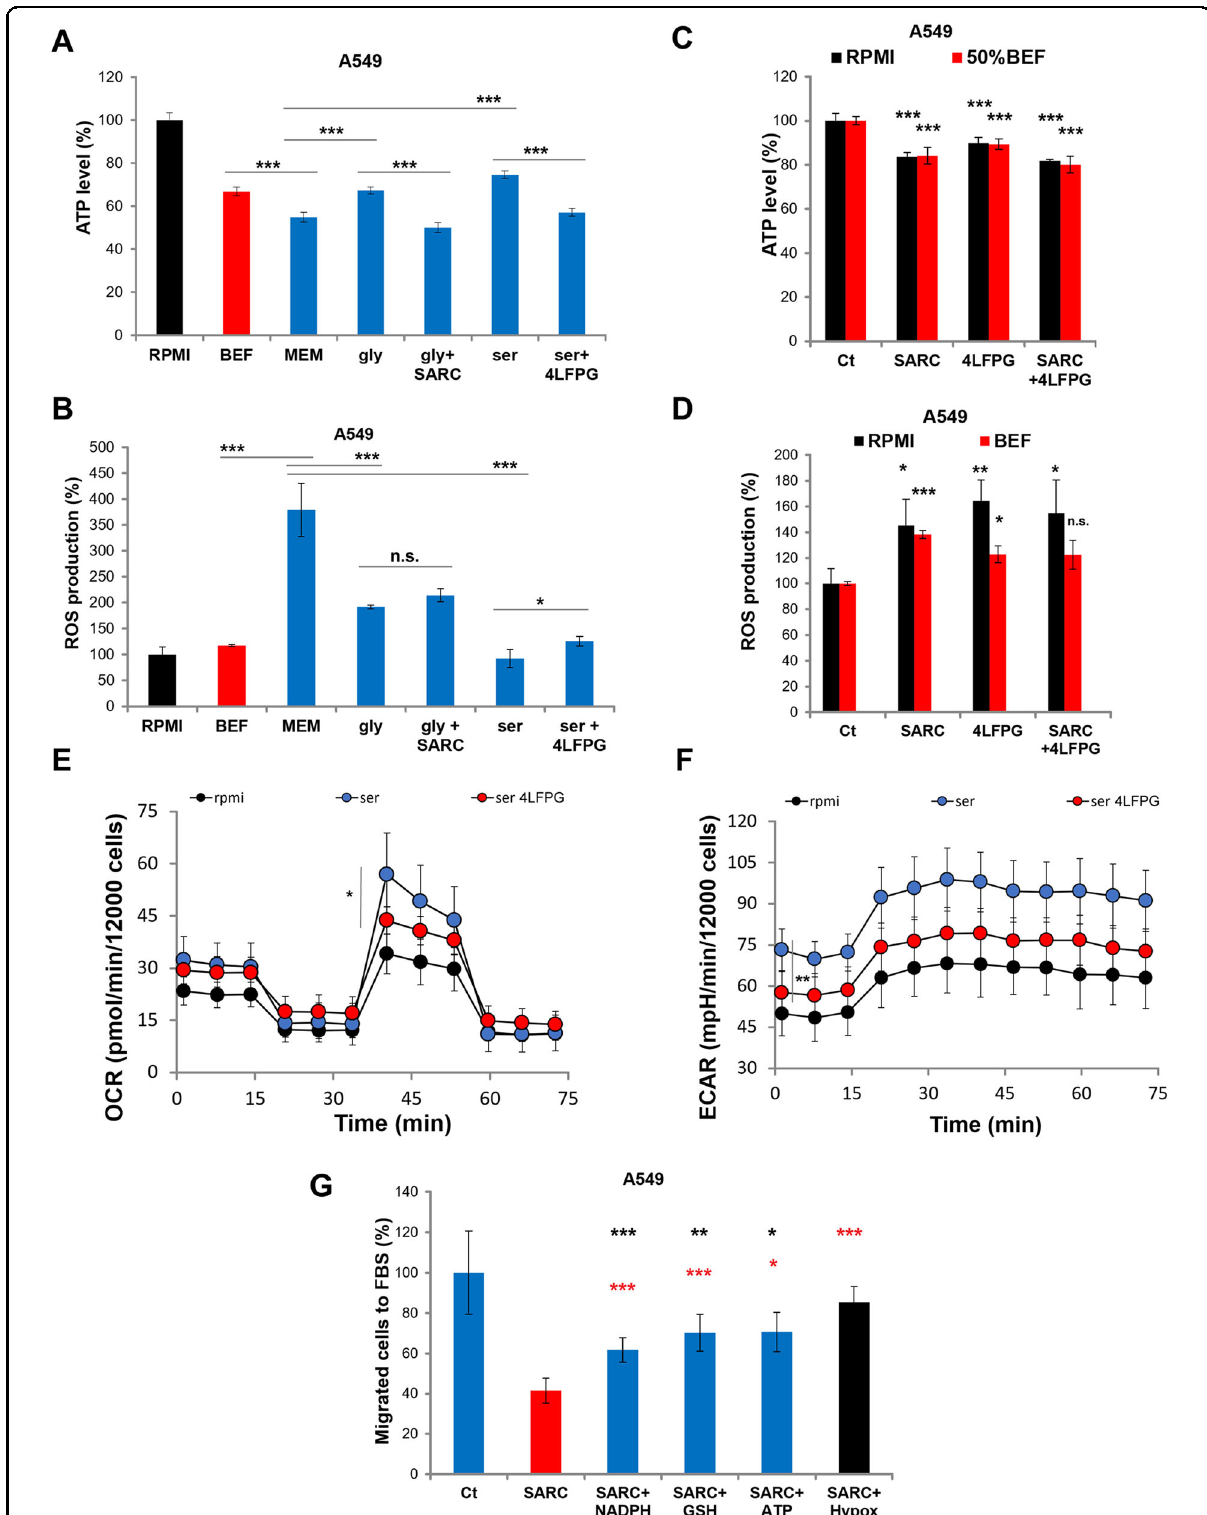
Fig. 5 (See legend on next